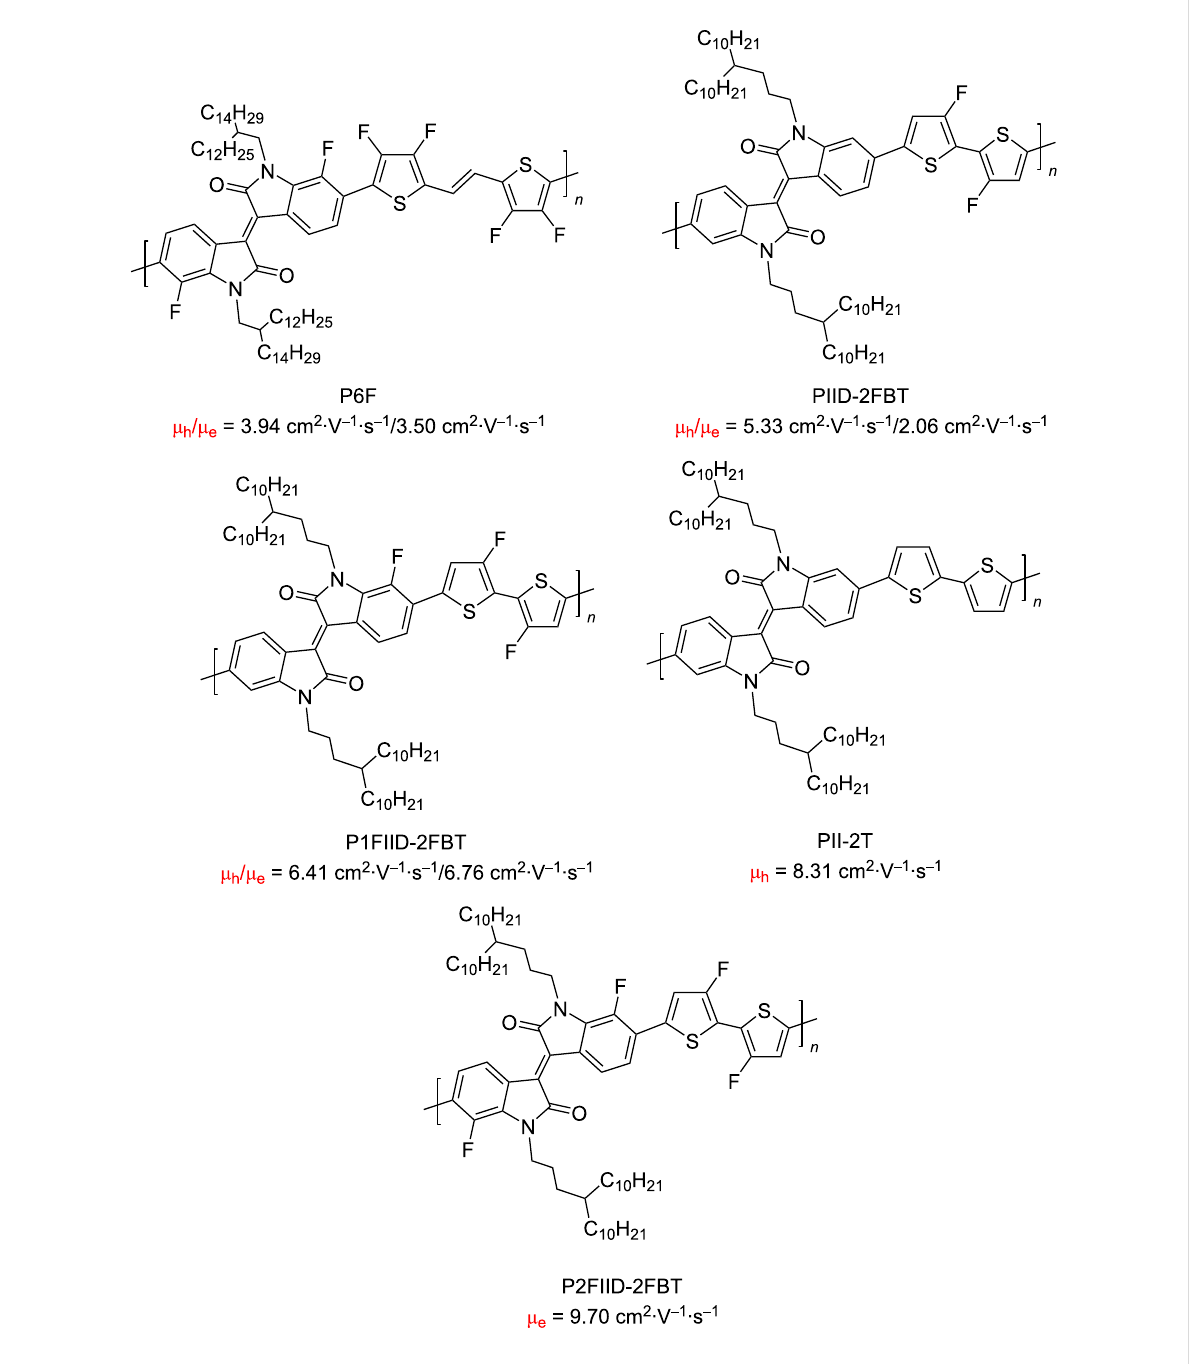
Scheme 22: Isoindigo derivatives for OFET technology with the best mobility.